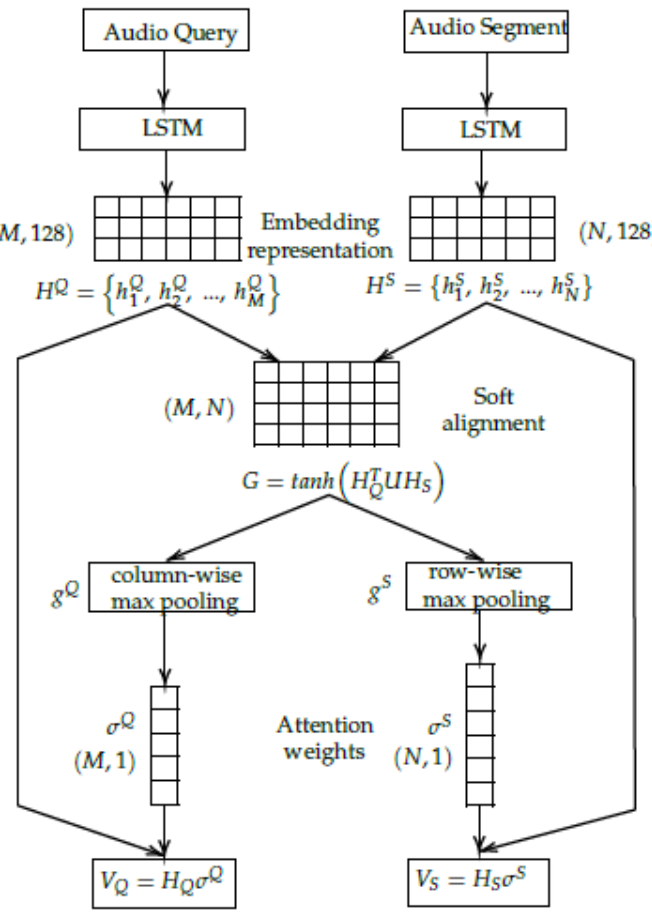
Figure 2. Attentive pooling network structure for the E2E + LA QbE STD